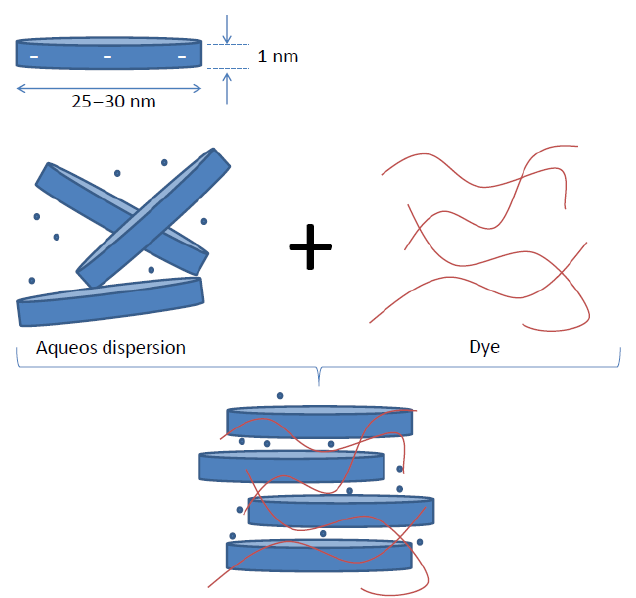
Figure 8. Laponite aqueous dispersion and dye adsorption. Synthetic Lap (Si 8 [Mg 5.5 Li 0.4 H 4.0 O 24 ] 0.7 − Na 0.7+ ) is a 2D clay disc-shaped silicate that is